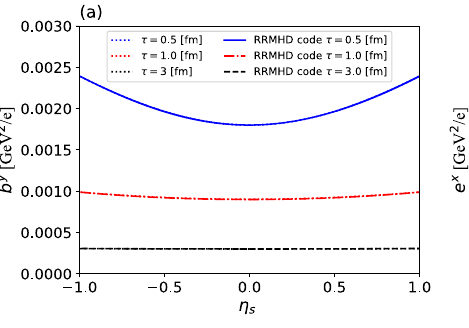
Fig. 17 We display a the magnetic field component b y and b the elec- tric field component measured in the comoving frame e x , respectively. The blue solid, red long dashed-dotted and black dashed lines show the